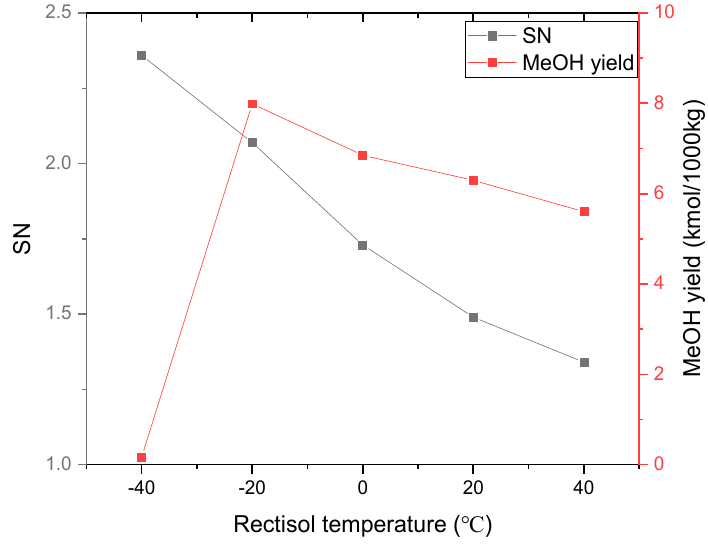
Figure 7. E ff ect of Rectisol temperature on SN and methanol yield (40 Figure 7. Effect of Rectisol temperature on SN and methanol yield (40 bar).